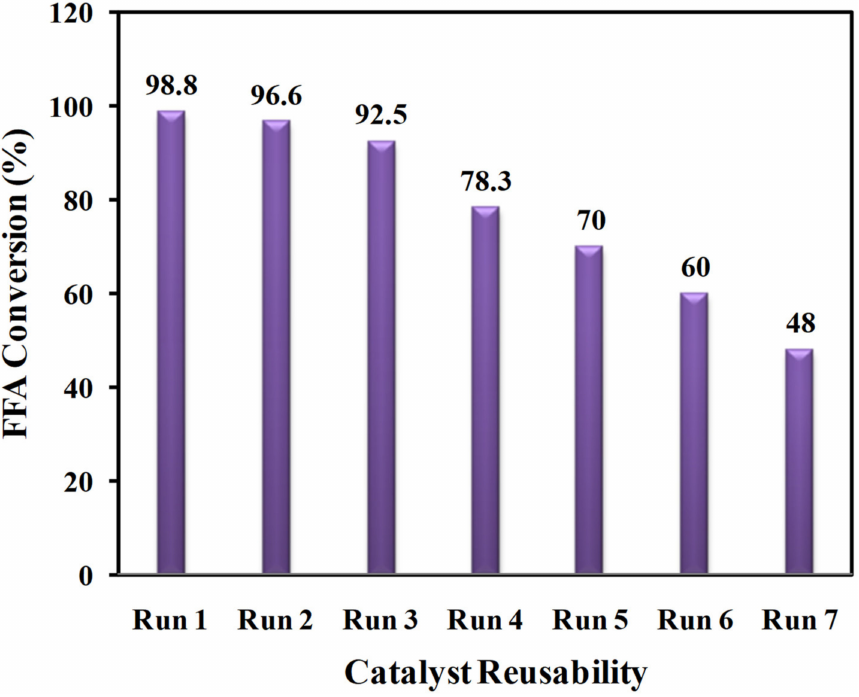
Figure 11. ReusabilitytestsoftheTPC-SO 3